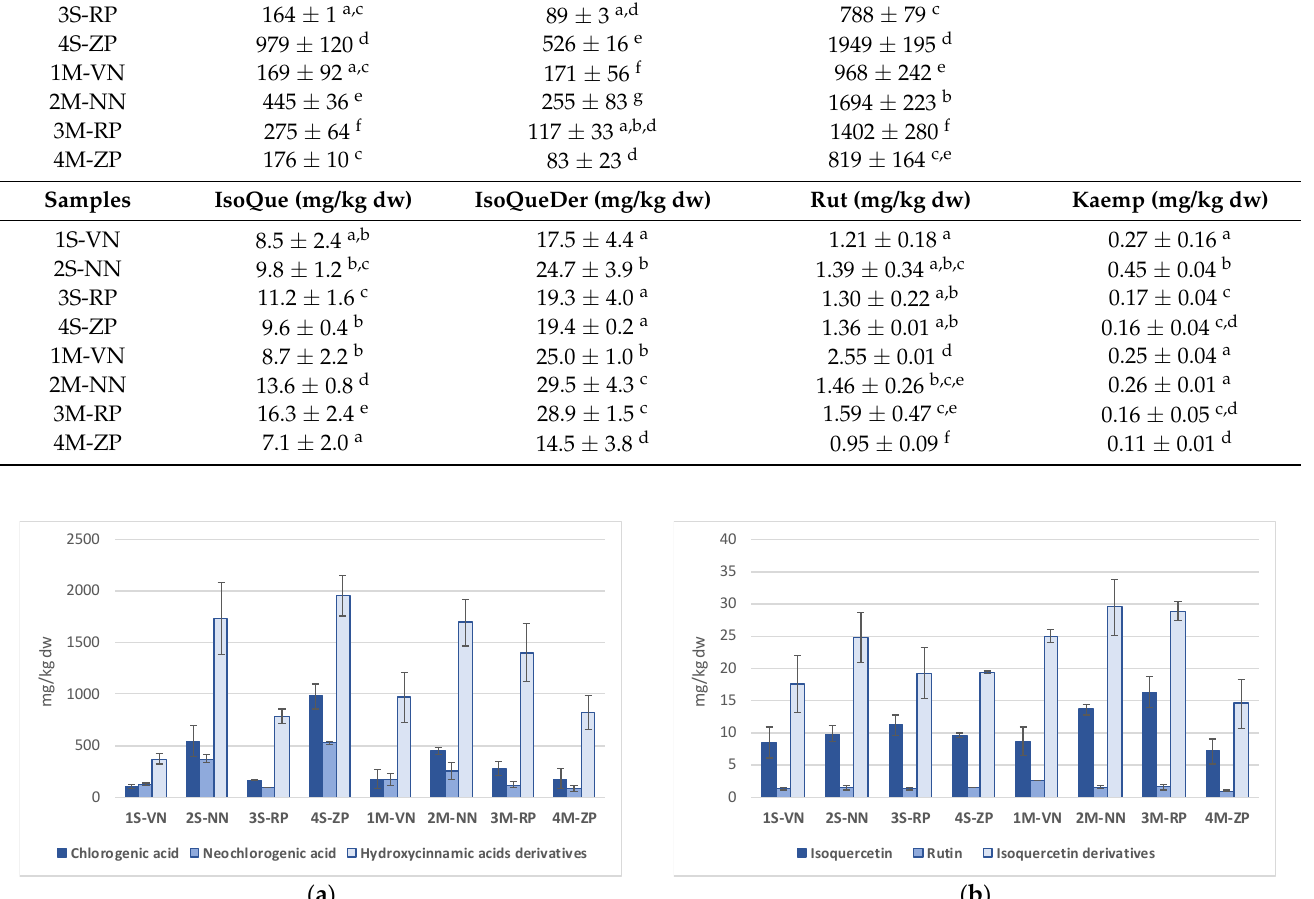
Figure 2. Histograms relevant to the contents of ( a ) chlorogenic acid (ChlAc), neochlorogenic acid (NeoChlAc), and hydroxycinnamic acids derivatives (HydcynDer) and ( b ) isoquercetin (IsoQue), isoquercetin derivatives (IsoQueDer), rutin (Rut) in hydroalcoholic extracts (MeOH/H 2 O; 80:20%, v/v ) of peaches and nectarines mesocarp samples. The values are expressed as mean ± SD ( n = 27; mg/kg dw). Table 4. Contents of chlorogenic acid (ChlAc), neochlorogenic acid (NeoChlAc), hydroxycinnamic acids derivatives (HydcynDer), isoquercetin (IsoQue), isoquercetin derivatives (IsoQueDer), rutin (Rut) and kaempferol (Kaemp) in hy- droalcoholic extracts (MeOH/H 2 O; 80:20%, v / v ) of peaches and nectarines mesocarp samples. The values are expressed as mean ± SD ( n = 27; mg/kg dw). Values marked with the same letter within the same column (for each analyte) are not statistically different (Tukey’s test, p > 0.05).